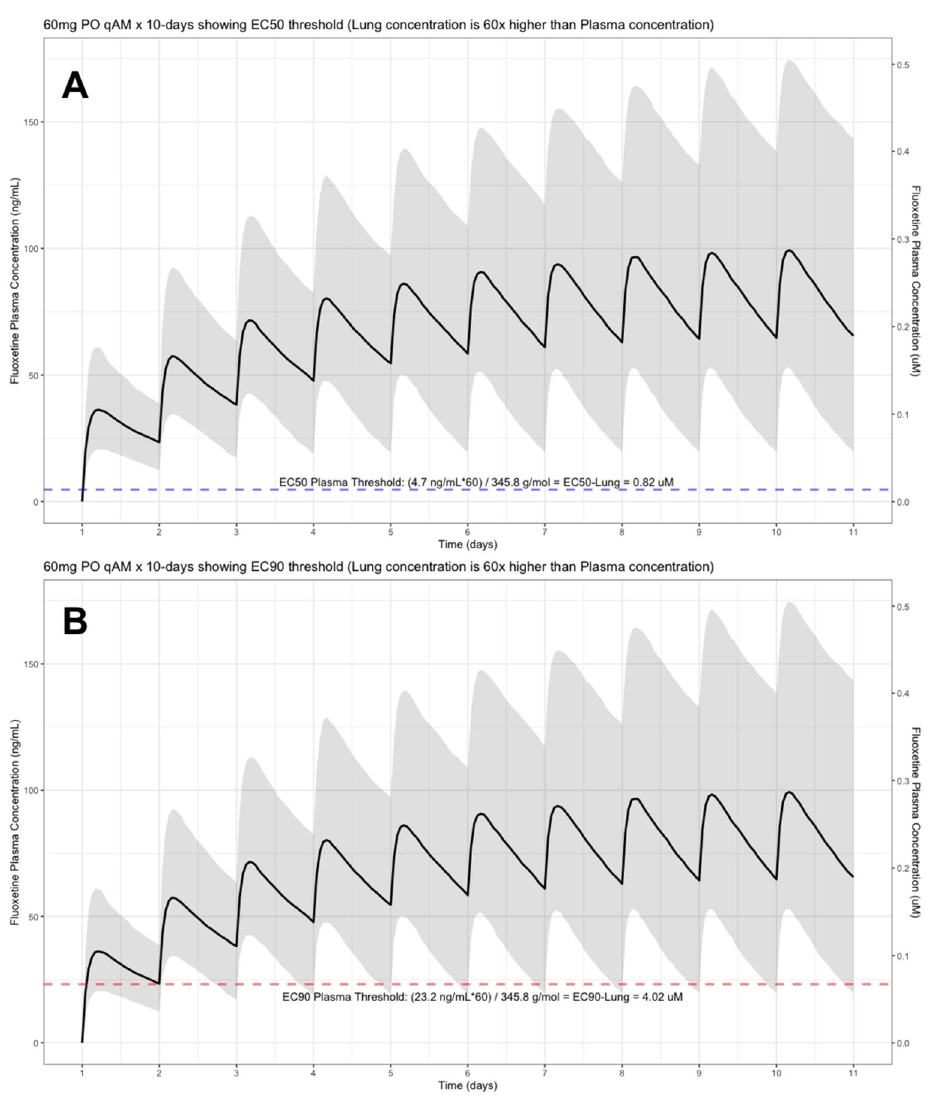
Figure 5. Fluoxetine population (n=1,000) dosing simulation results for an oral dose of 60 mg/day for 10 days. The shaded regions illustrate the 10th (lower) and 90th (upper) percentiles with the solid line within the shaded region representing the median fluoxetine concentration. The dashed horizontal line depicts the effective concen- tration resulting (A) 50% and (B) 90% inhibition (EC90) of SARS-CoV-2 that will result in 60-times higher level in the